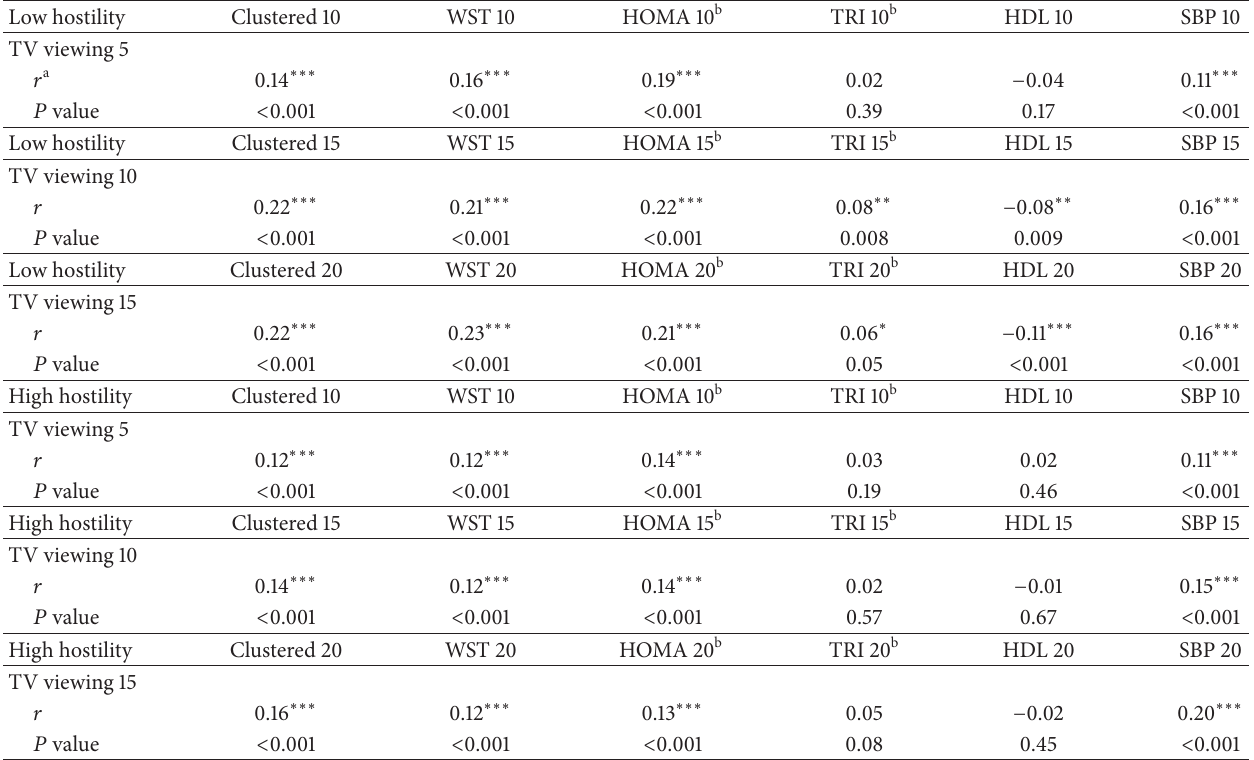
Table 3: Correlations between TV viewing and cardiometabolic risk variables by hostility, CARDIA,